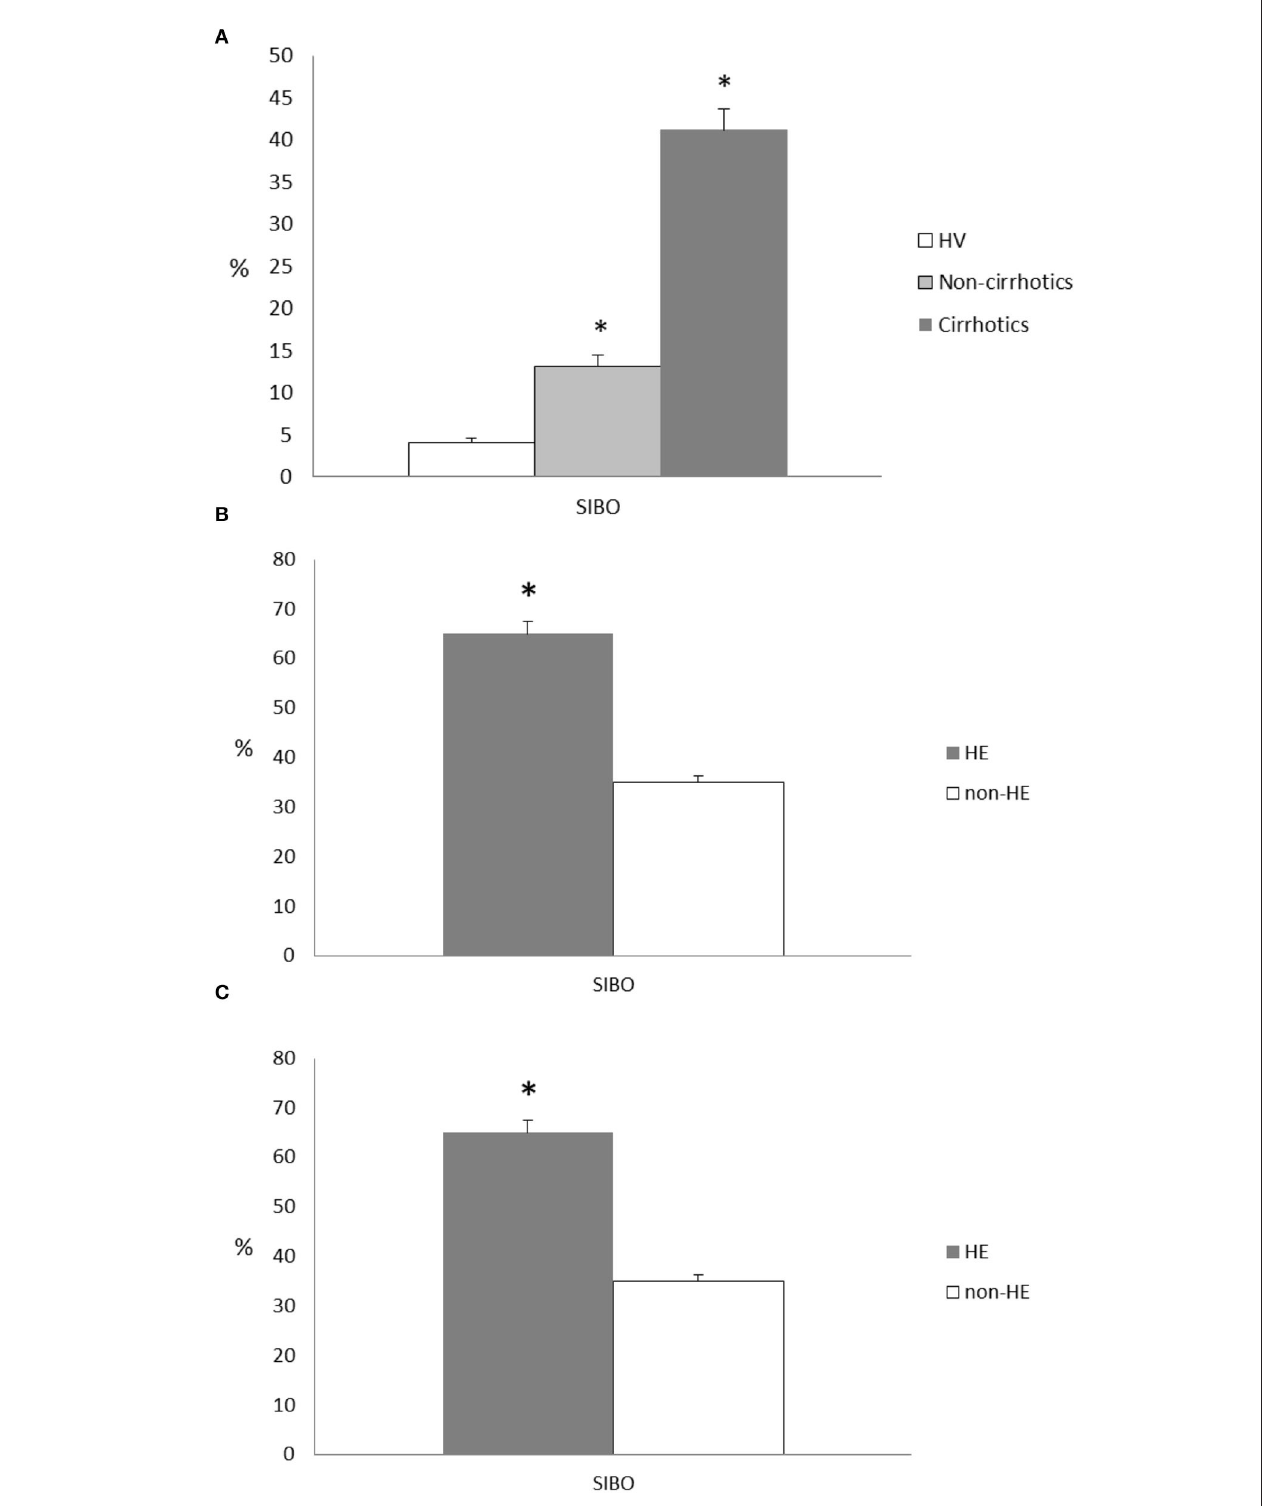
FIGURE 1 | (A) SIBO prevalence in the healthy volunteers (HVs) vs. the cirrhotic and non-cirrhotic patients; all * p < 0.05. SIBO, small intestinal bacterial overgrowth. (B) SIBO prevalence according to Child-Pugh status in the cirrhotic patients; * p < 0.05. Comparisons between Child-Pugh class B or C and class A were made by Fisher’s exact test. SIBO, small intestinal bacterial overgrowth. (C) SIBO prevalence according to presence or absence of HE in cirrhotic patients; * p < 0.05. SIBO, small intestinal bacterial overgrowth; HE, hepatic encephalopathy.